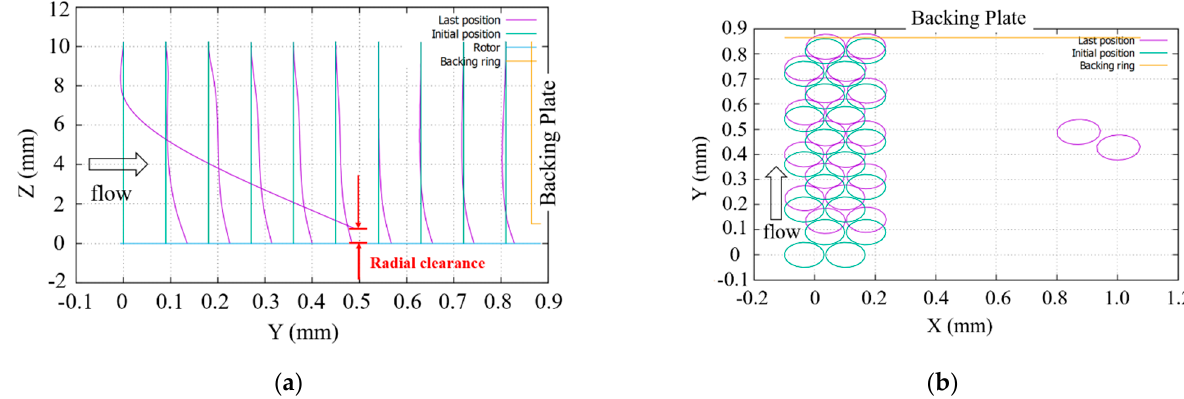
Figure 2. Circumferential slip of bristles at swirl velocity of 250 m/s. ( a ) Bristle centerlines on the axial—radial plane. ( b ) Bristle tips on the axial—circumferential plane.